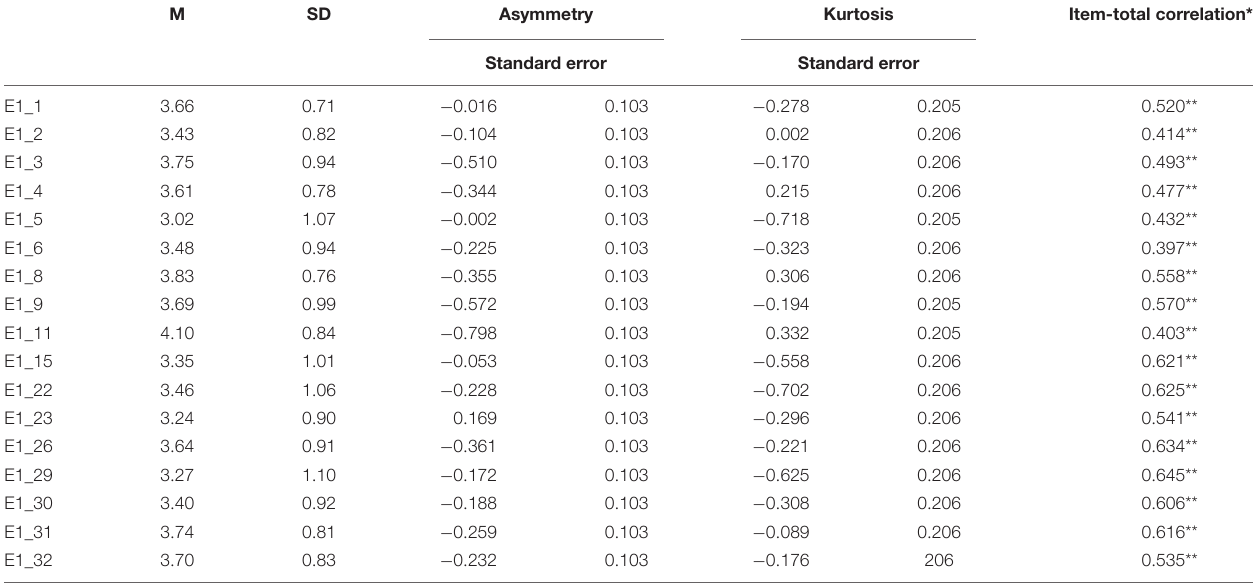
TABLE 1 | Descriptive statistics, indices of asymmetry and kurtosis, and item-total correlation.